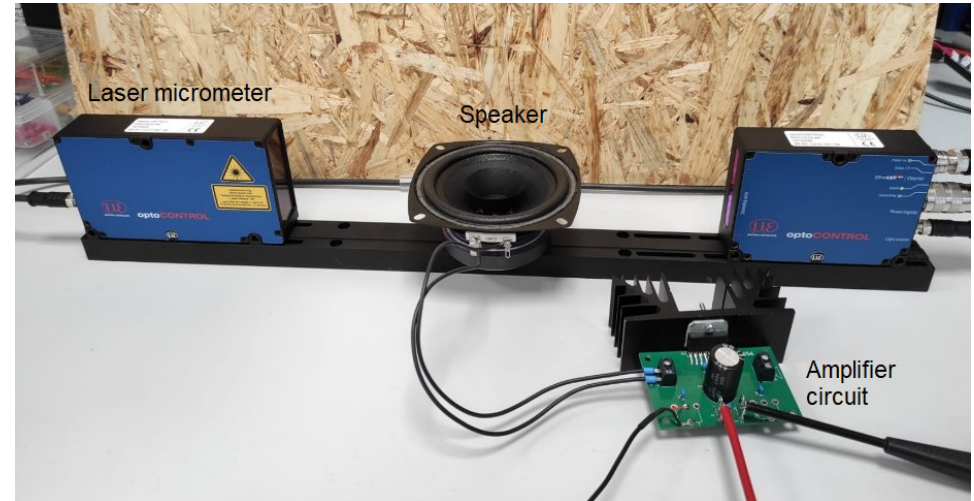
Figure 5. Neonatal simulator made up of an amplifier circuit with cooling body, a speaker and the laser